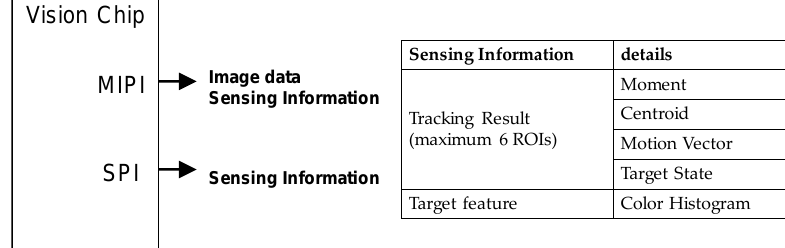
Figure 11. Output information. Figure 11. Output